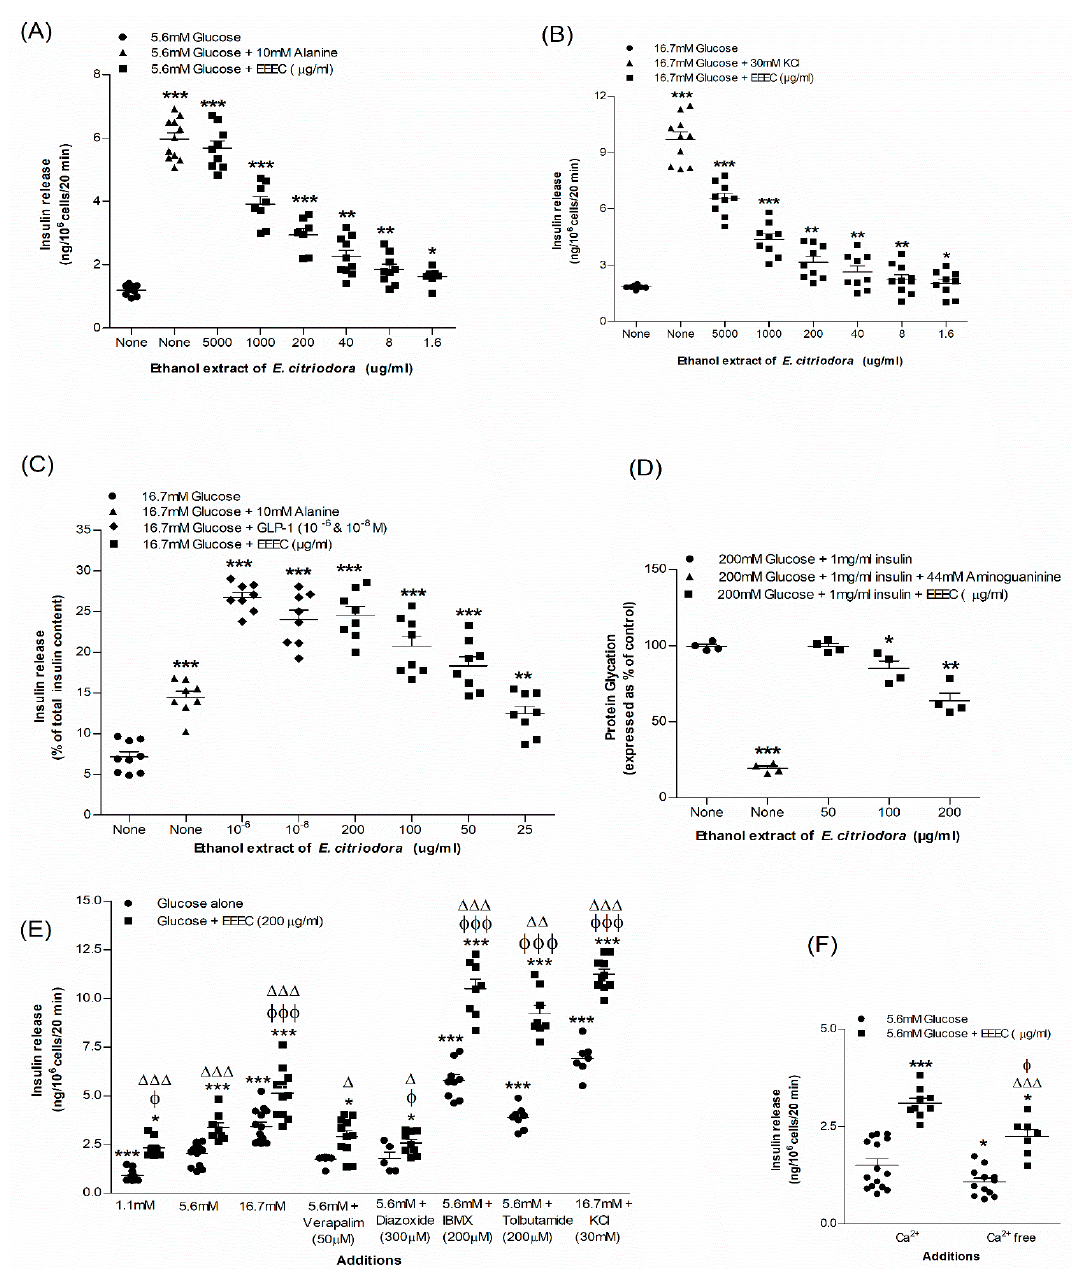
Figure 2. Effects of EEEC on insulin secretion from ( A , B ) clonal pancreatic β -cells (BRIN-BD11) and ( C ) islets of Langerhans, ( D ) glycation of protein, ( E ) secretion of insulin with known stimulators or inhibitors and ( F ) plus or minus extracellular calcium from clonal β -cells. Values n = 8 and 4 for